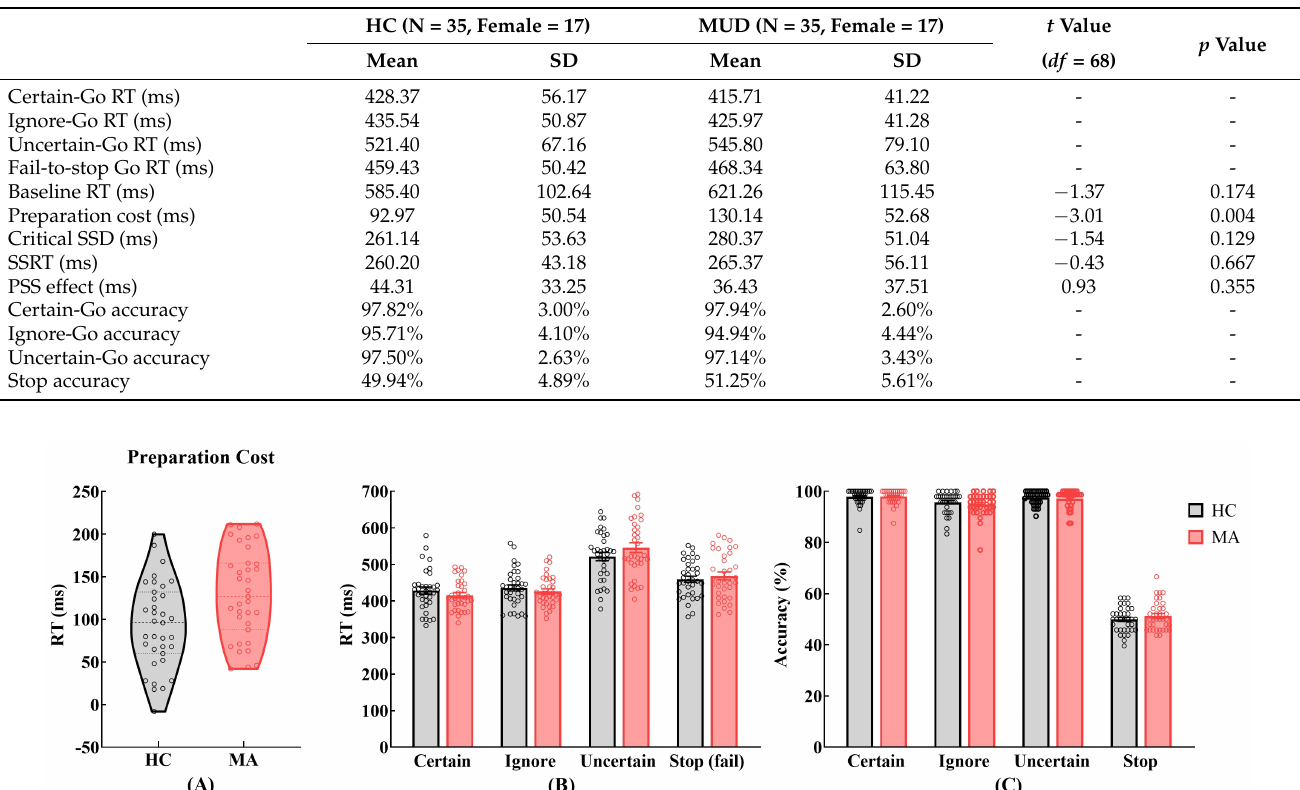
Table 3. Behavioral variables of MUD and HC participants.